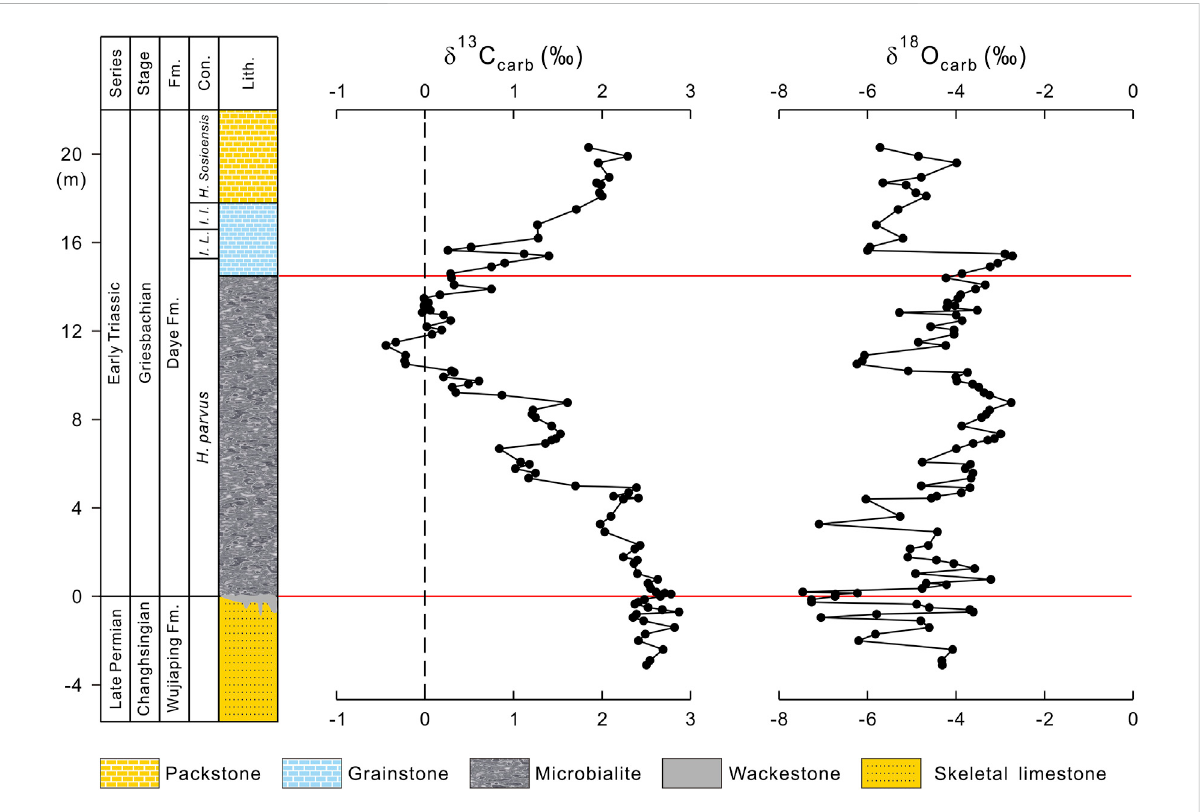
FIGURE 2 Pro fi les of δ 13 C carb and δ 18 O carb from the Dajiang section. Conodont zones are from Jiang et al. (2014). Abbreviations: H. parvus = Hindeodus parvus zone; I. L. = Isarcicella lobate zone; I. I. = Isarcicella isarcica zone; H. sosioensis = Hindeodus sosioensis zone; Fm. = Formation; Con. = Conodont zone; Lith. =